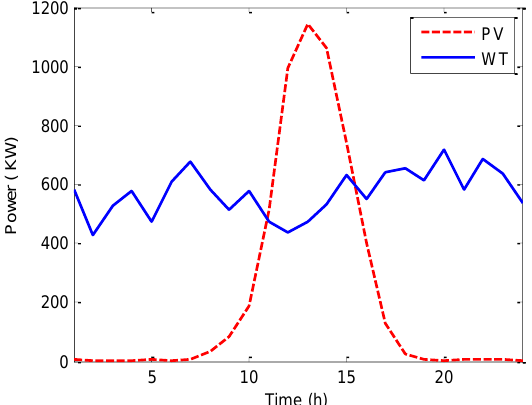
Figure 15. Power produced by RES for 24 h (first scenario).